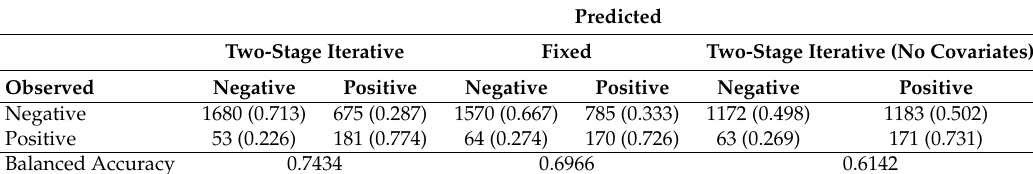
Table A3. Confusion matrix. Cut-off point = 0.09.